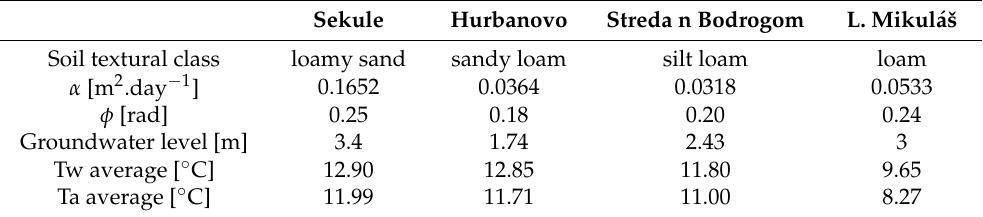
Figure 7. Simulated ( Ts,sim ) and measured groundwater temperatures ( Tw,obs ) at the mean depth of the groundwater level over the period 2013–2016 ( left ); relation between measured and modelled values ( right ). Table 4. Parameters α and φ for selected stations (results of the TGWAT model calibration) over the period